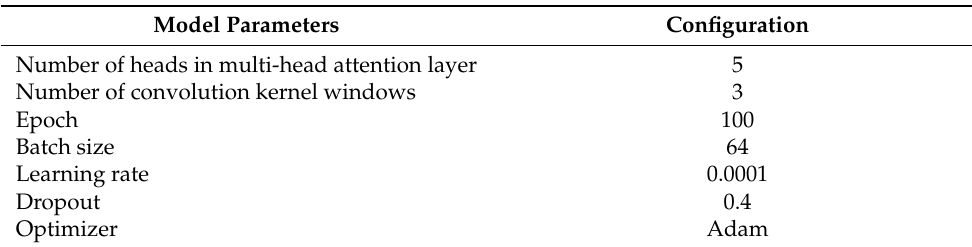
Table 7. Model parameter setting.